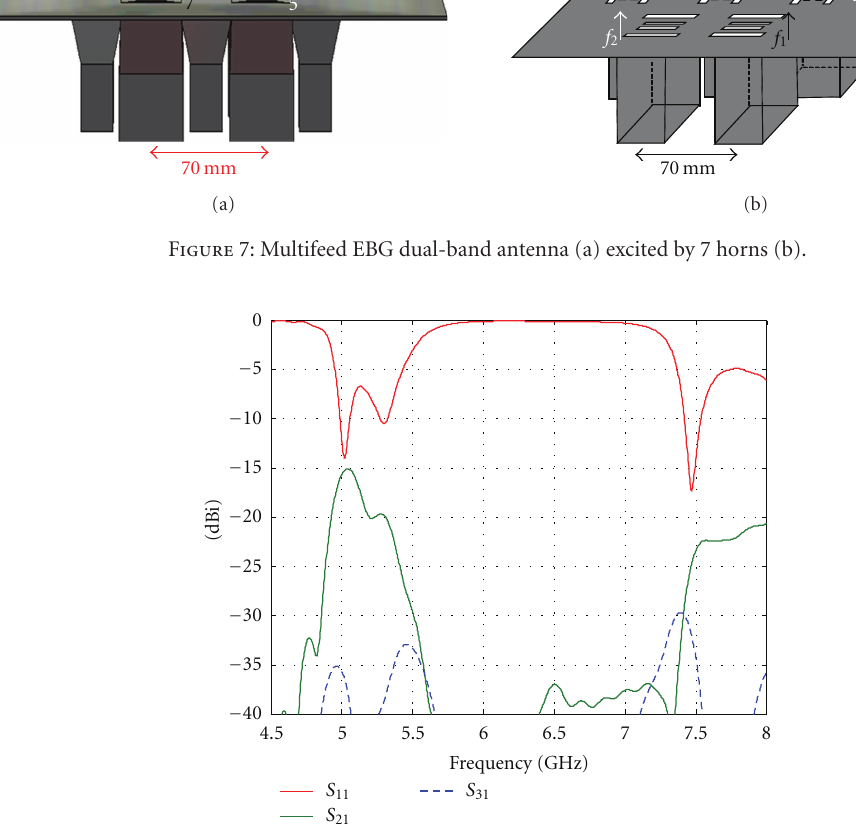
Figure 8: S-parameters of the multifeed EBG antenna when port 1 is